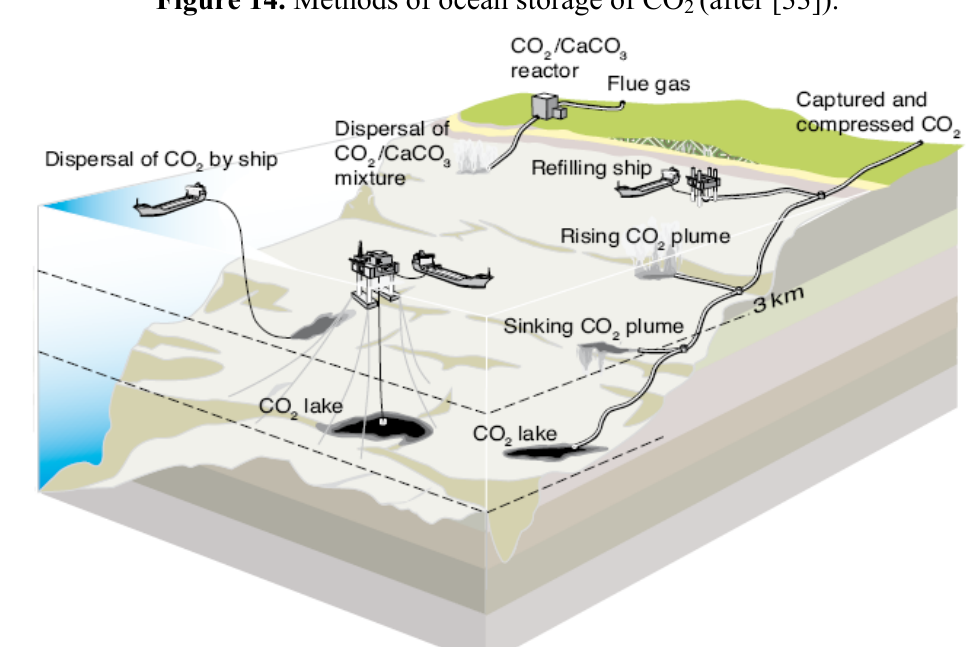
Figure 14. Methods of ocean storage of CO